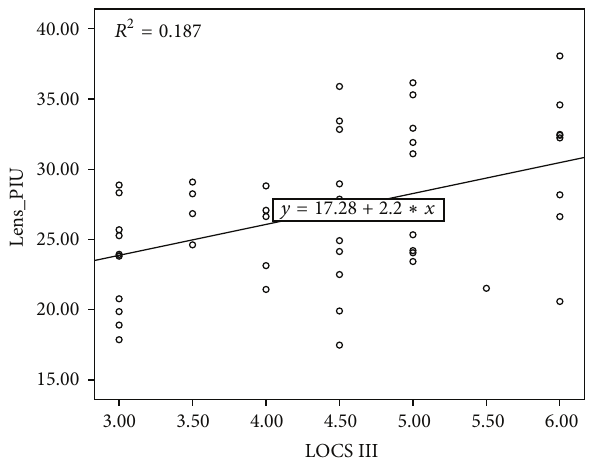
Figure 2: The relationship between whole lens opacity density measured using optical coherence tomography (OCT) and LOCS